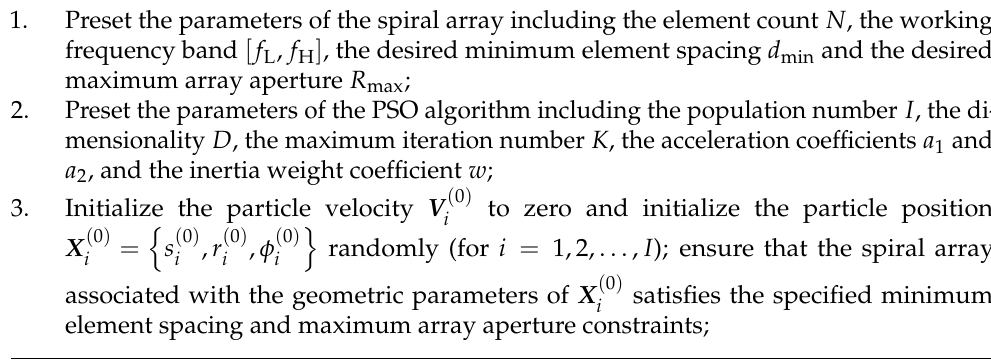
Algorithm 1 The PSO-based synthesis procedure for optimizing geometric parameters of spiral